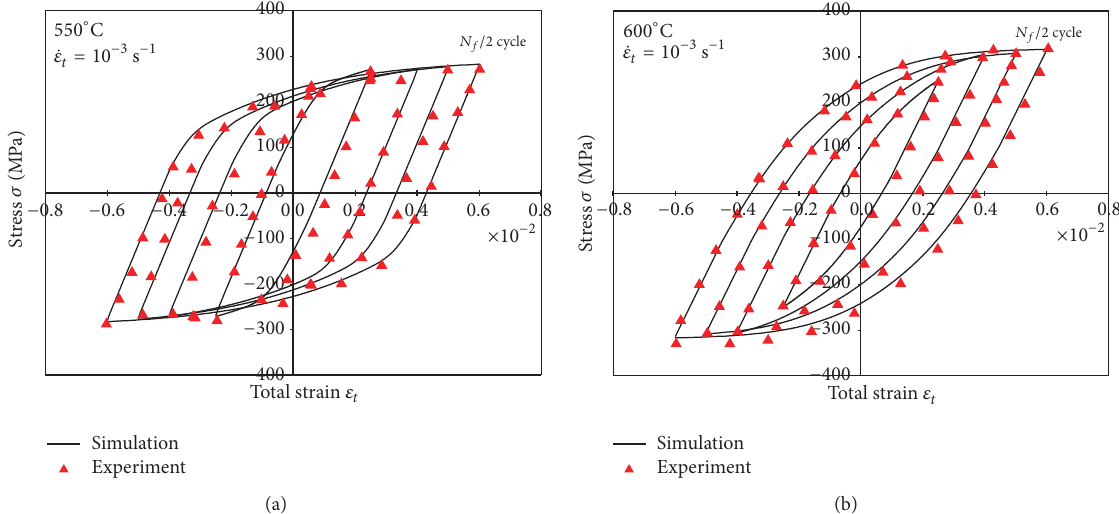
Figure 6: Stress-strain hysteresis loops at half-life cycles for several strain ranges for (a) a modified 9Cr-1Mo steel and (b) a 316 stainless steel.